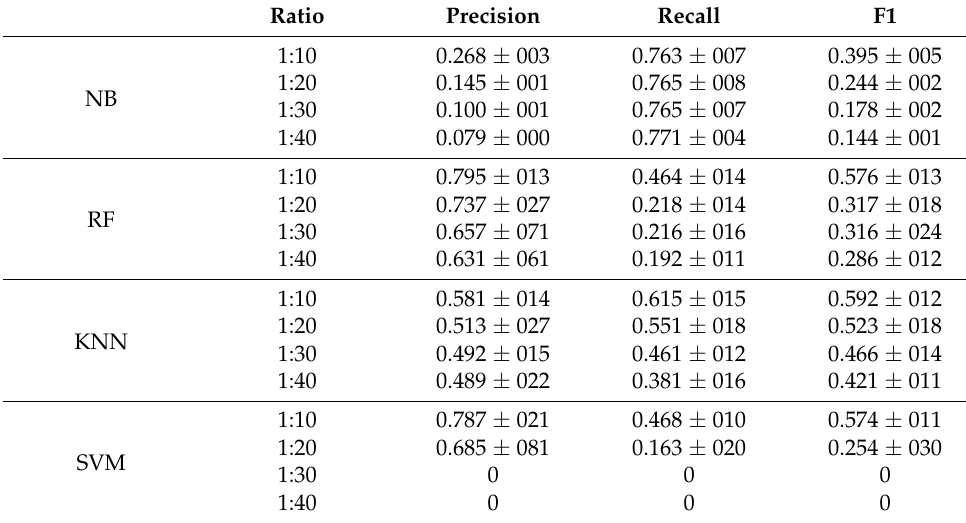
Table 1. Results for permissions and APIs used as features together.